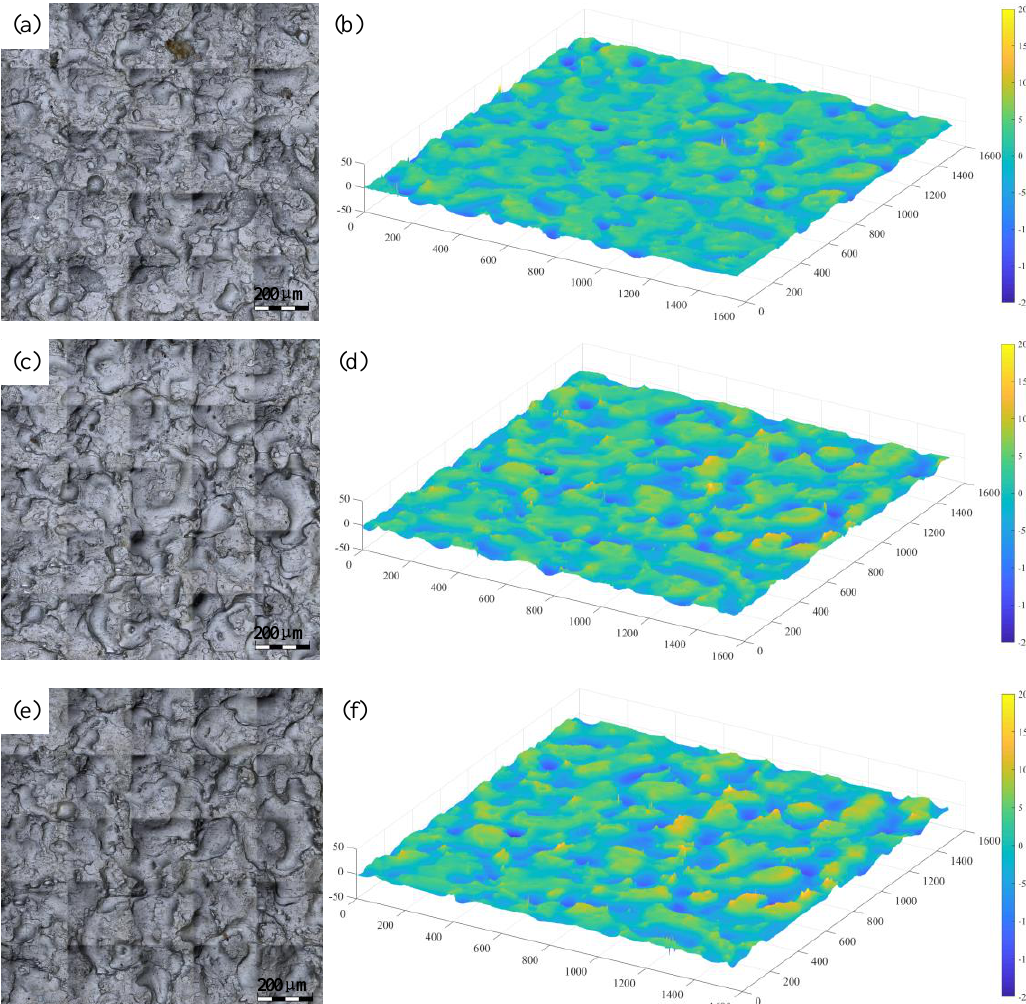
Figure 8. Strip surface topography after rolling (the Sa of roll 3.5 µ m), ( a ) and ( b ) 5% reduction, ( c ) and ( d ) 7% reduction, ( e ) and ( f ) 10% reduction.